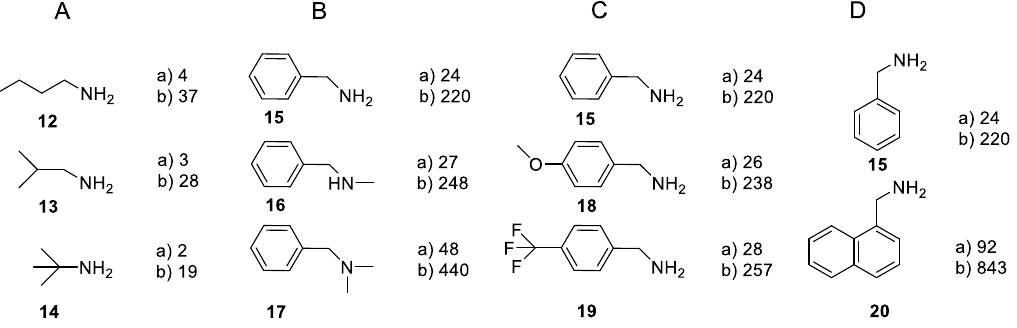
Figure 2. Bulk liquid membrane cell used for phase transport studies (active transfer surface: 7.07 × 10 −4 m 2 ).